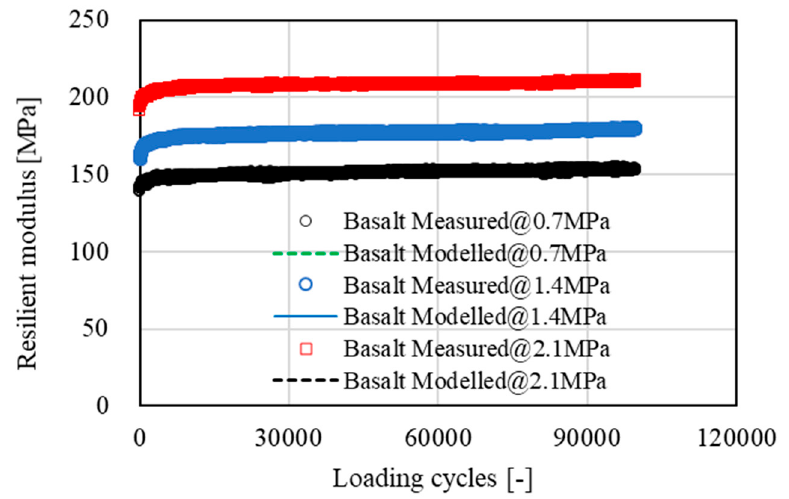
Figure 7. Development of resilient modulus of basalt aggregate under cyclic loading.